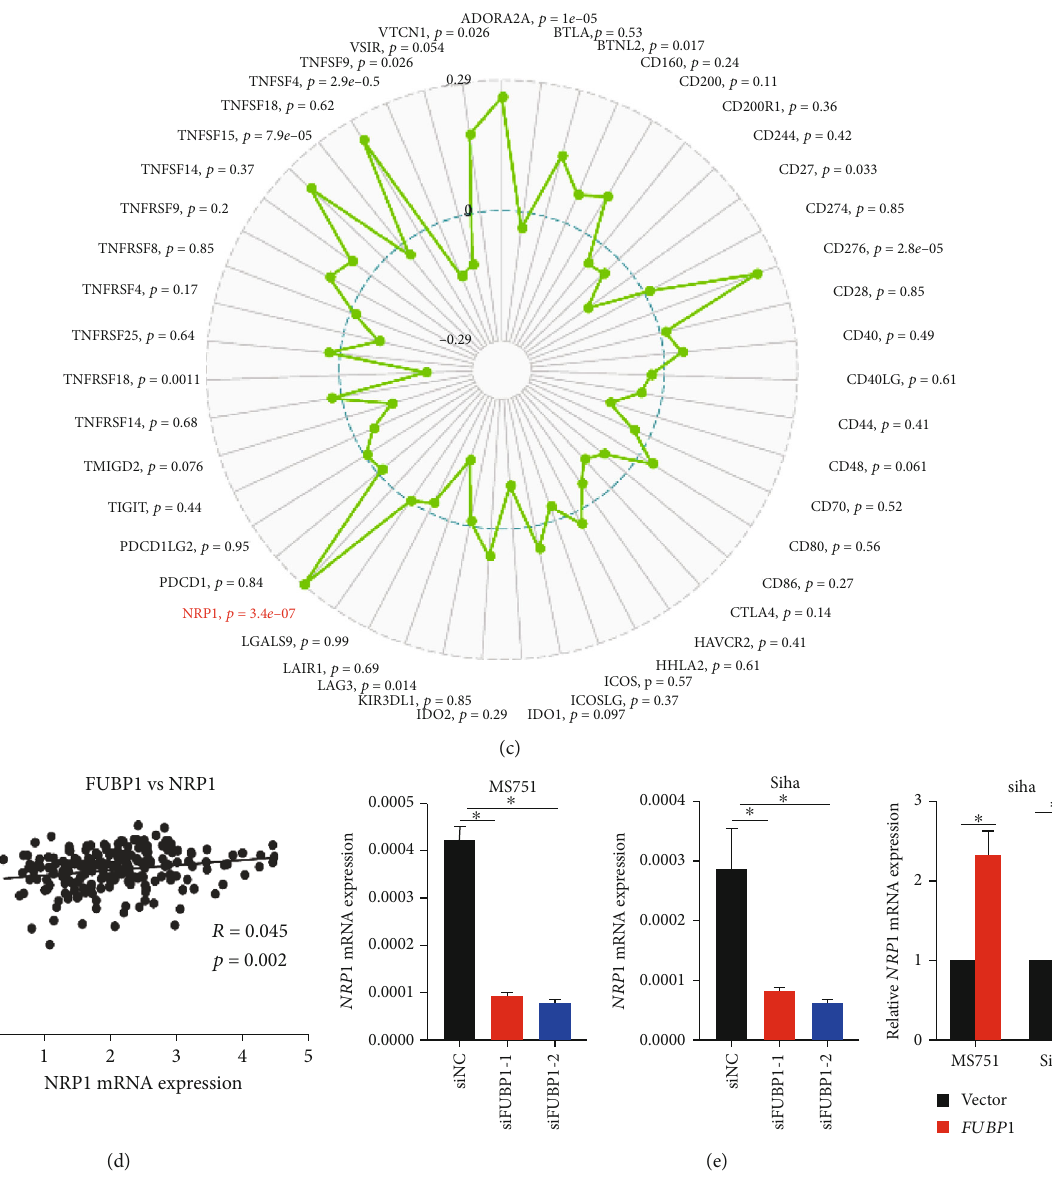
Figure 3: FUBP1 contributed to tumor immune evasion by regulating NRP1 expression. (a) The abundances of immune in fi ltrates are estimated by TIMER algorithm. (b, c) Gene-immune analysis of FUBP1 in CC conducted on Sanger box. (d) The correlation between expression levels of FUBP1 and NRP1 in CC. (e) The mRNA level of NRP1 in MS751 and Siha after FUBP1 knockdown or overexpression. Error bars represent mean ± standard error of mean. Two-tailed t -test, ∗ p < 0 : 05